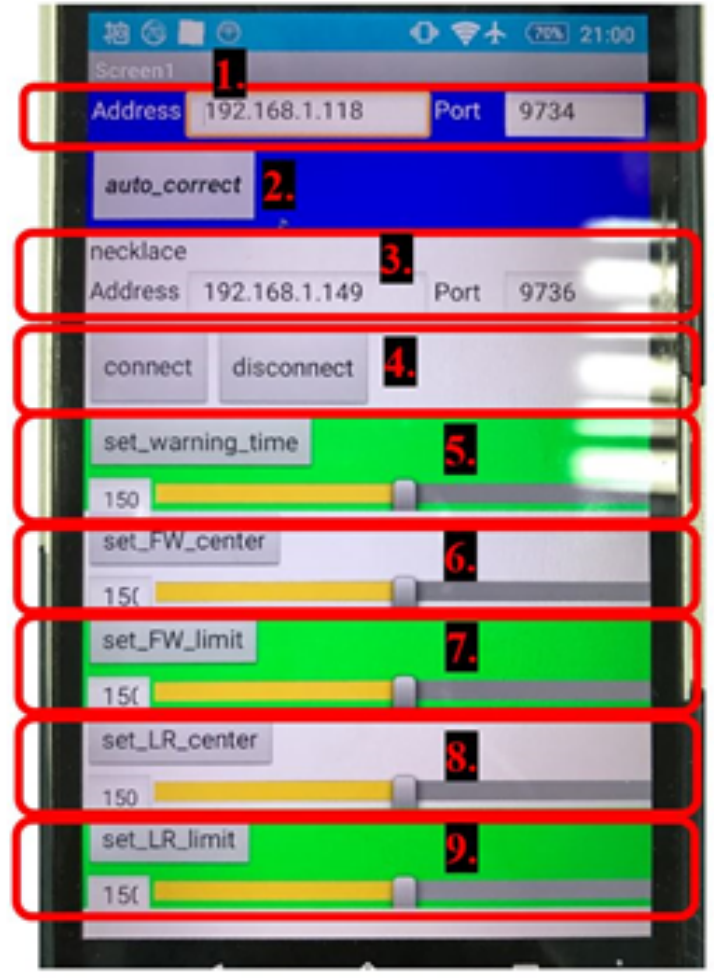
Figure 10. Mobile app